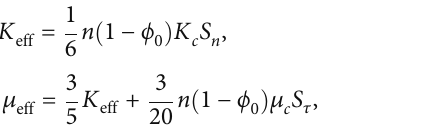
Figure 9: The cross plot between porosity and P-wave and S-wave velocity of sandy conglomerates samples in the study